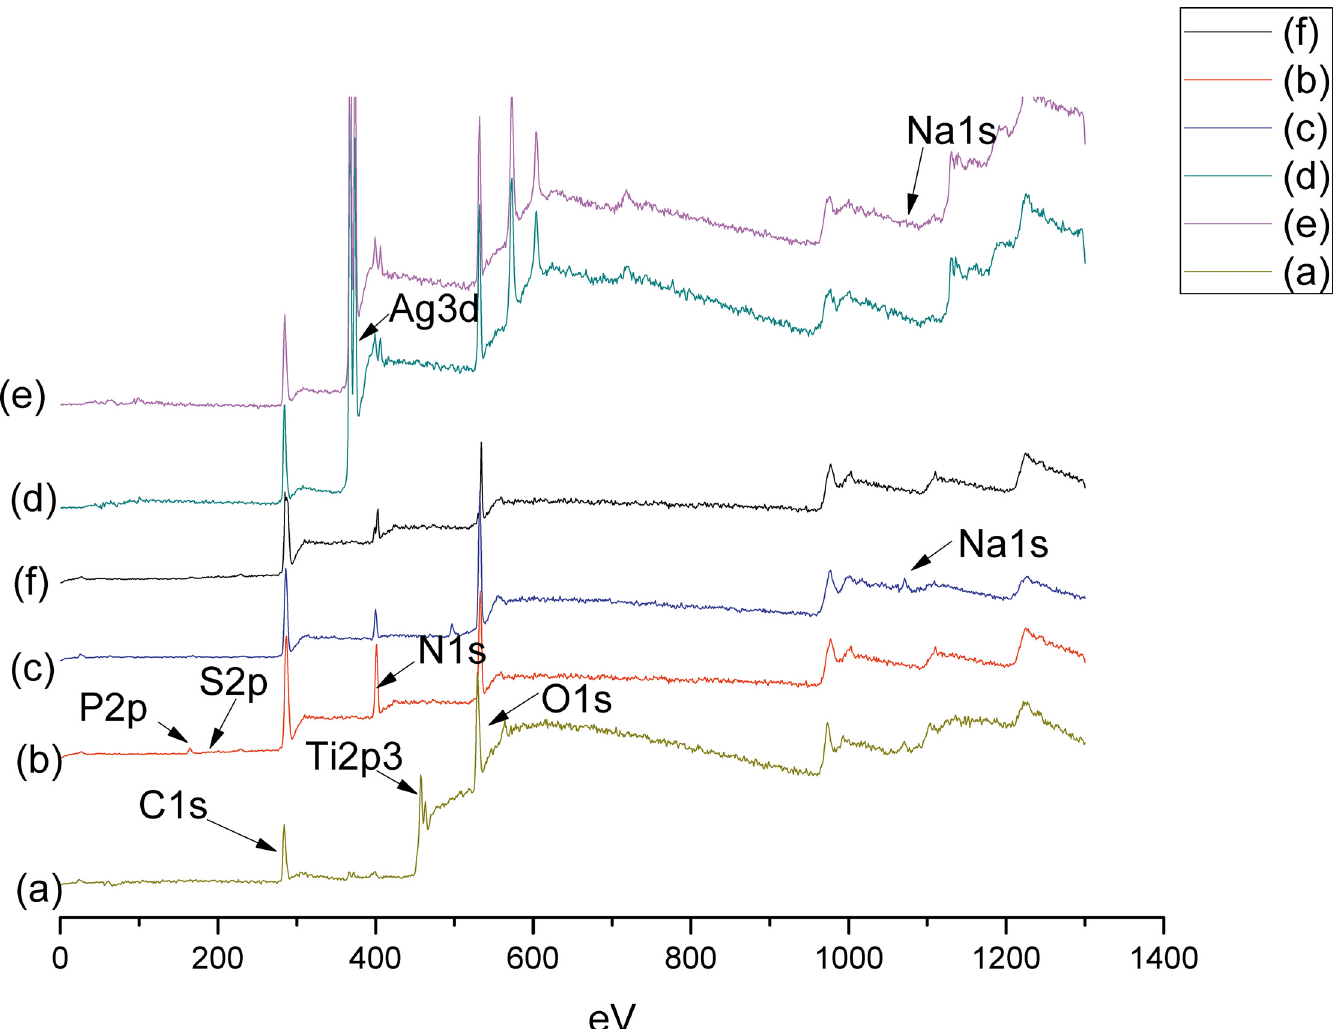
Fig 2. XPS wide-scan spectra of (a) pristine Ti, (b) PTL treated Ti (Ti-PTL), (c) Ti-PTL-HA, (d) Ti-PTL-HA-CS/Ag, (e) Ti-PTL-HA-CS/Ag – HA, (f) Ti- PTL-HA-CS after immersion for 7days.